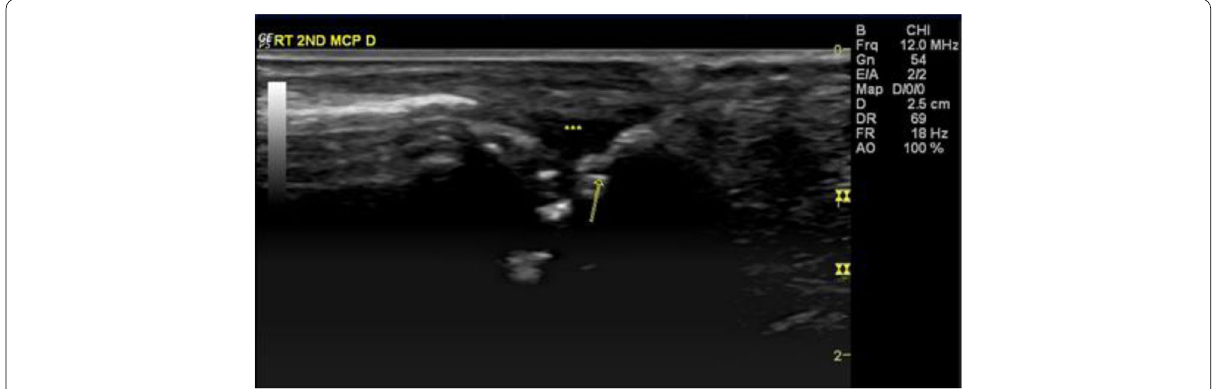
Fig. 4 Longitudinal gray scale ultrasound scan of the dorsal surface of right 2nd metacarpophalangeal (MCP) showing hypoechoic partially displaceable, poorly compressible tissue occupying the joint space and distending the capsule. Also, there are multiple areas of intraarticular discontinuity of the cortical bony surface (erosions) (yellow arrow), also seen in the transverse section (TS)